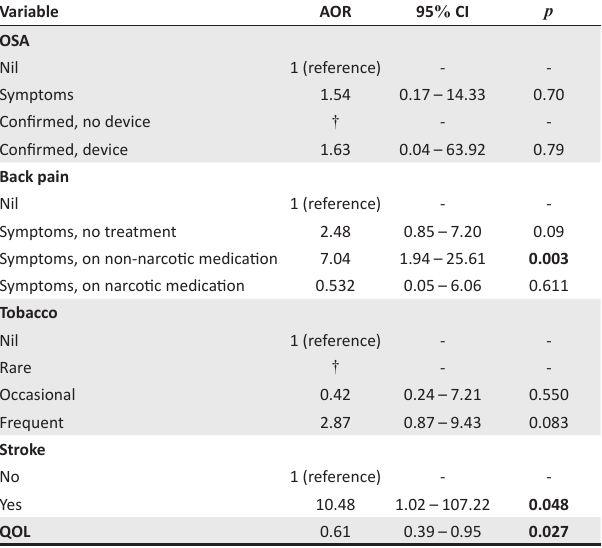
TABLE 4: Association between clinical features, demographic characteristics and depression: multivariate logistic regression